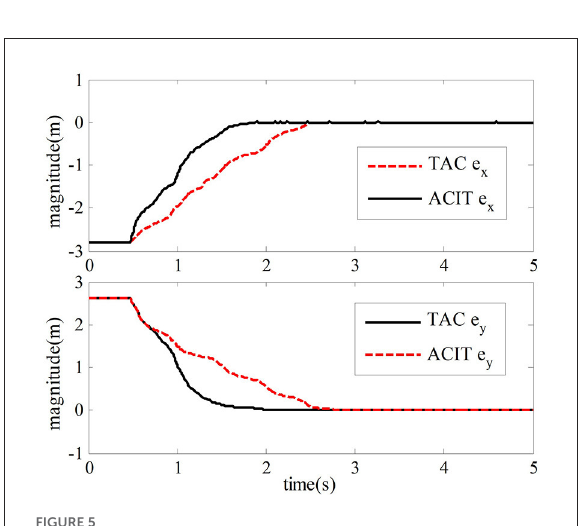
FIGURE5 Tracking error of the end position of the